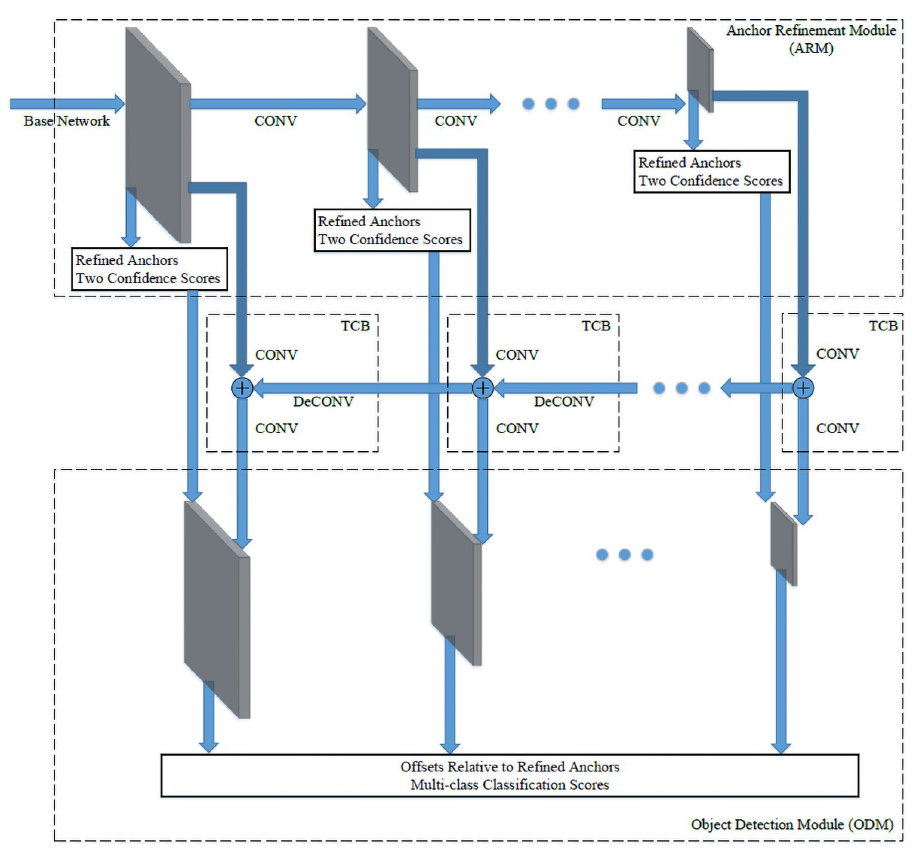
Fig 4. RefineDet structure. The architecture has three modules: Anchor refinement module (ARM), transfer connection block (TCB), and object detection module (ODM).